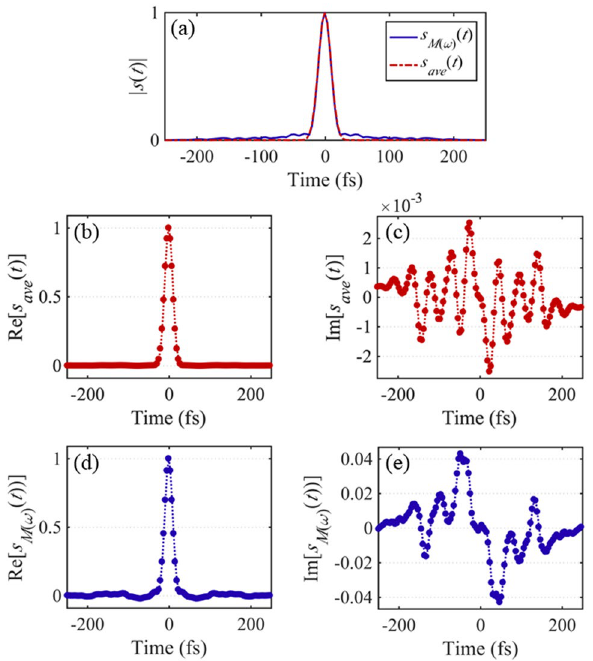
Figure 7. RANA approach spectral retrieval from the trace frequency marginal in the presence of instability. ( a ) The magnitudes of s ave ( t ) = F −1 { S ave ( ω )}, and s M ( ω ) ( t ) = √F −1 { M SHG ( ω )} corresponding to the train with τ FWHM = 54 fs are plotted by the dashed red and the solid blue curves, respectively. ( b , and c ) Real and imaginary parts of s ave ( t ). ( d , and e ) Sign-ambiguity-removed curves of s M ( ω ) ( t ). As shown, there is an expected discrepancy between s ave ( t ) and s M ( ω ) ( t ). When instability is present, we do not expect to obtain the exact average spectrum from the frequency marginal. The above result is as good an estimate of an individual pulse spectrum as can be expected and turns out to be a good initial guess for the retrieval algorithm.